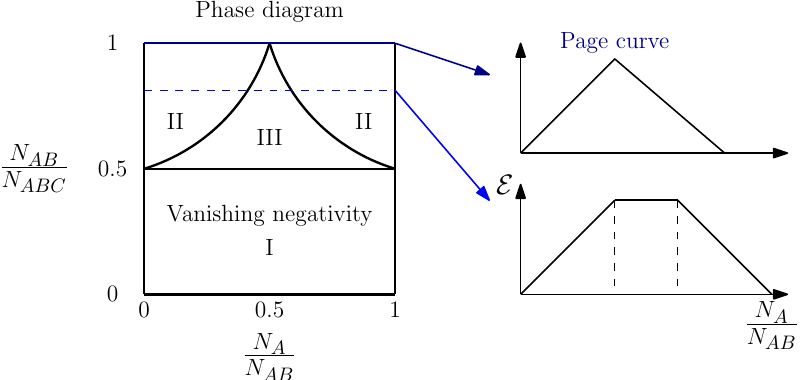
Figure 2 . Phase diagram for the entanglement in a random mixed state. For a given fixed L C , the logarithmic negativity is shown on the right. In this figure, L is the Hilbert space dimension, and N = log L is the number of qudits. In the pure state limit, there is the Page curve for entanglement, being proportional to the size of the smaller subsystem min { log L there is a plateau in the Page curve in a region of the phase diagram where multipartite entanglement is